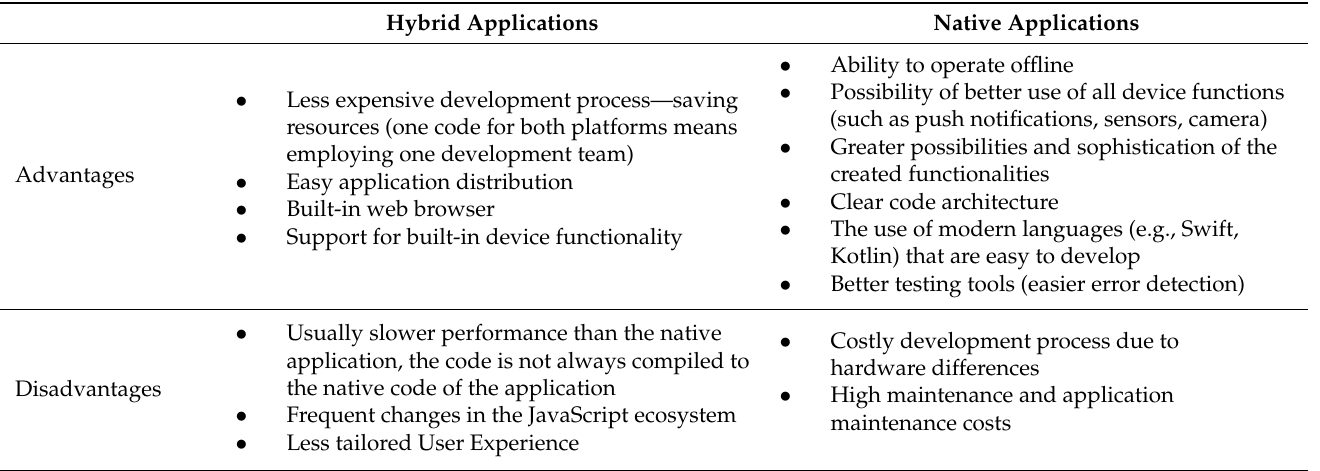
Table 1. Summary of the differences between hybrid and native